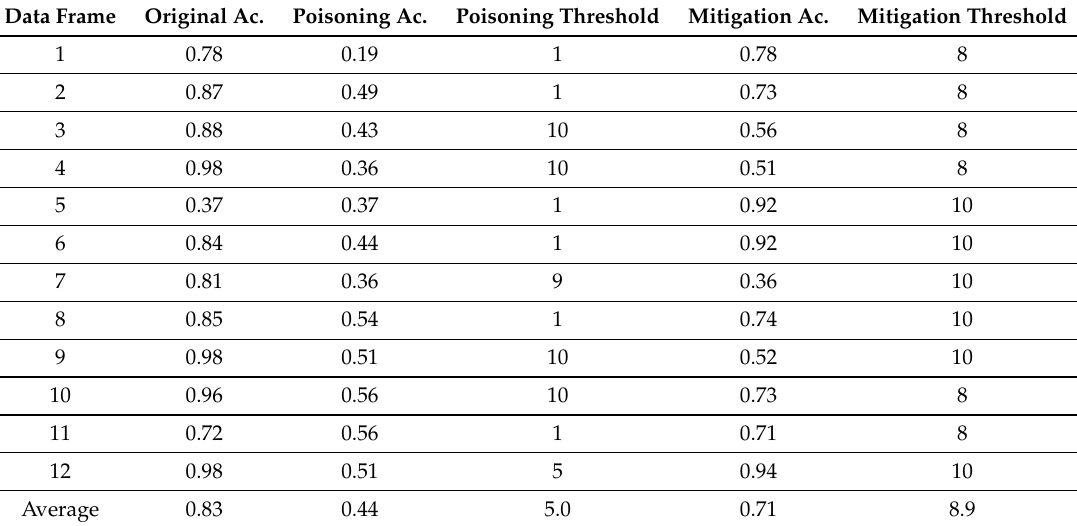
Table 4. Dynamic Adversarial Attacks and Mitigation Relabeling.